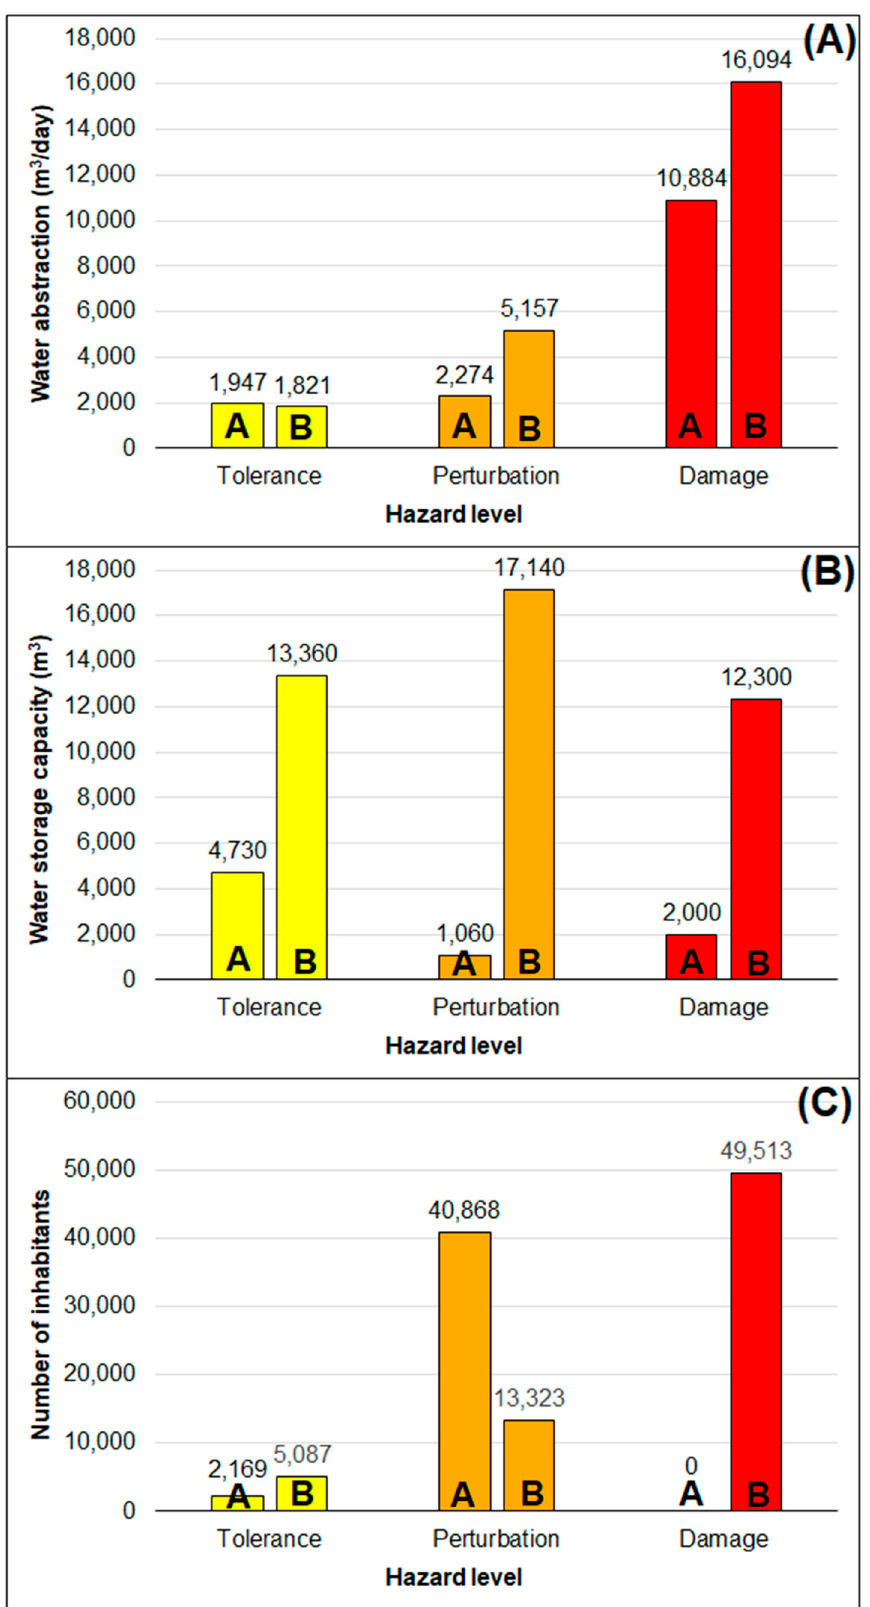
Figure 4. Cartographic representation of the impacts of eruptive scenario B, respectively, for: ( A ) Volume of water being abstracted; ( B ) storage capacity of the reservoirs; ( C ) number of inhabitants being served by the system over the water supply system of Ponta Delgada.